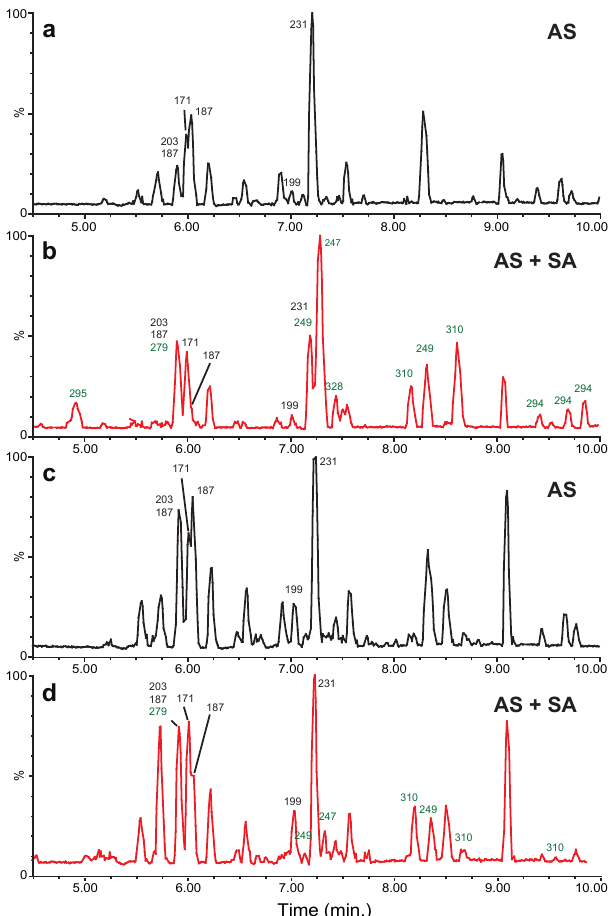
Fig. 6. UPLC/(-)ESI-TOF chromatograms from the filter sam- ples of high-NO x photooxidation of α -pinene. (a) HONO was the OH source, AS seed particles (4-HONO) (b) HONO was the OH source, AS+SA seed particles (6-HONO), (c) CH 3 ONO was the OH source, AS seed particles (10-MeONO), and (d) CH 3 ONO was the OH source, AS+SA seed particles (12-MeONO). Chromato- graphic peaks designated with black [ M − H ] − ions are carboxylic acids and chromatographic peaks designated with green [ M − H ] − ions are organosulfates and nitrooxy organosulfates. See Table 2 for compound